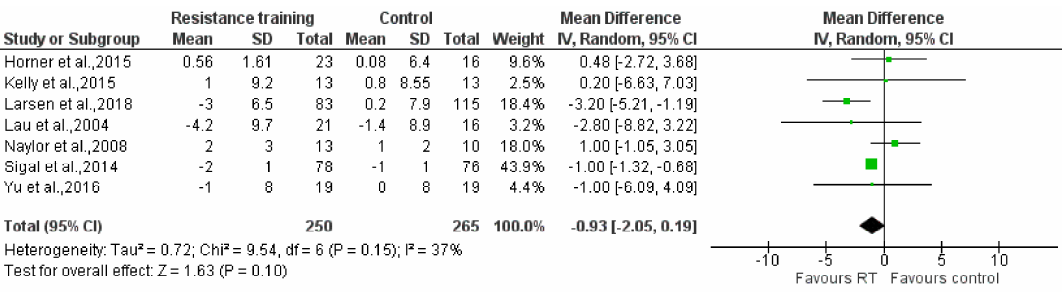
Figure 3. The e ff ect of Resistance Training on systolic blood pressure (mmHg). Total: total number of Figure 3. The effect of Resistance Training on systolic blood pressure (mmHg). Total: total number of Figure 3. The effect of Resistance Training on systolic blood pressure (mmHg). Total: total number of Figure 3. The effect of Resistance Training on systolic blood pressure (mmHg). Total: total number of subjects; CI: confidence interval. subjects; CI: confidence interval. subjects; CI: confidence interval. subjects; CI: confidence interval.